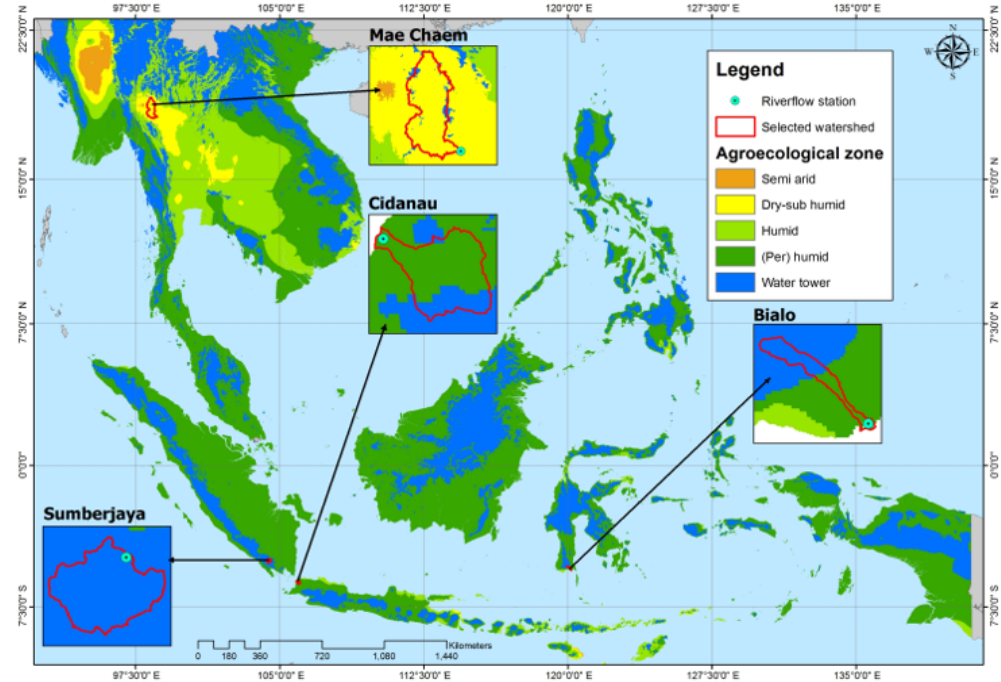
Figure 1. Location of the four watersheds in the agro-ecological zones of Southeast Asia (water towers are defined on the basis of its ability to generate river flow and being in the upper part of a